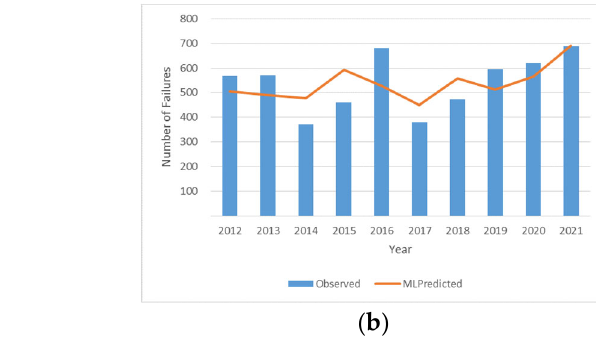
Figure 7. Annual plot of pipe failures. ( a ) MCMC estimation; ( b ) ML estimation.